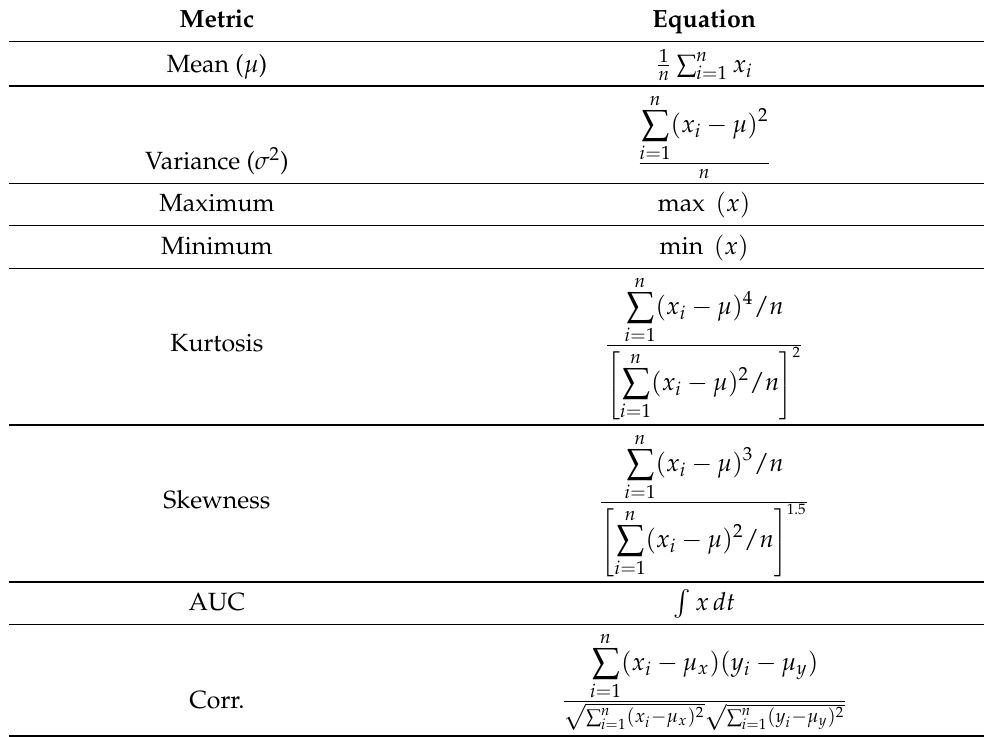
Table 1. Features extracted from brain hemodynamics